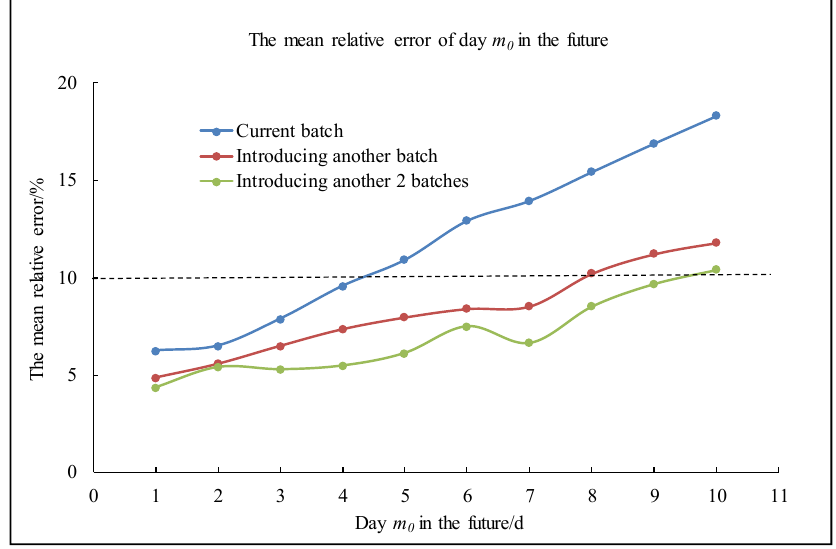
Figure 10. Comparison chart of the mean relative error of predicted future fresh weight.